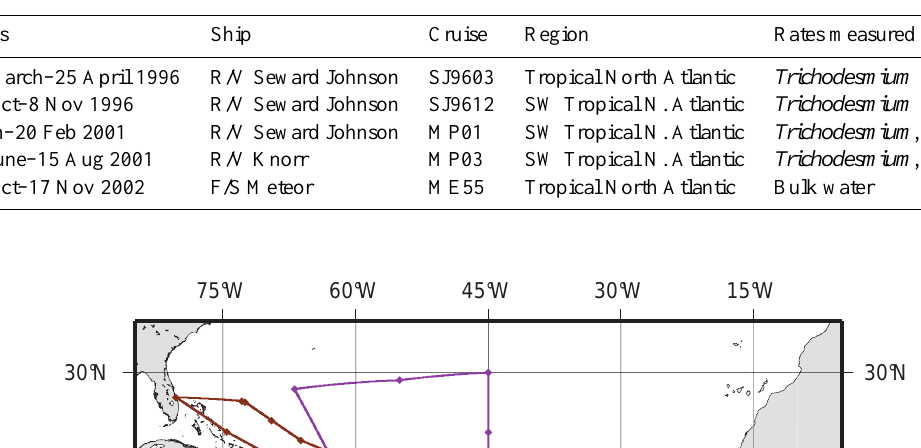
Table 1. Cruises included in this study.